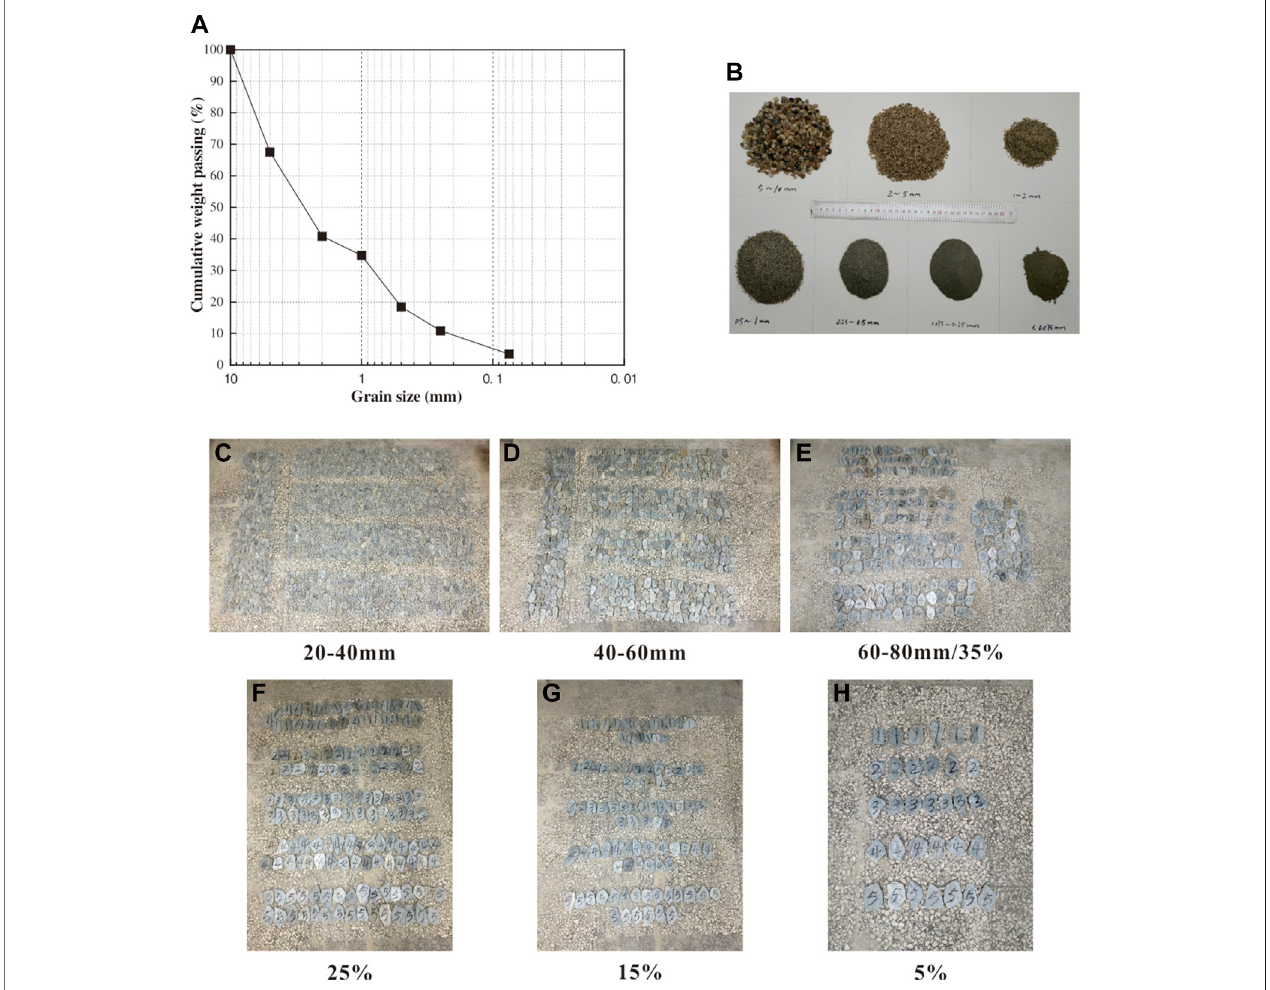
FIGURE 4 | Experimental materials. (A) Grain size distribution of the phyllite soil; (B) Raw sand matrix materials; (C – E) Phyllite block sizes of 20 – 40, 40 – 60 and 60 – 80 mm, respectively; (E – H) Phyllite block percentages of 35%, 25%, 15%, and 5%, respectively.